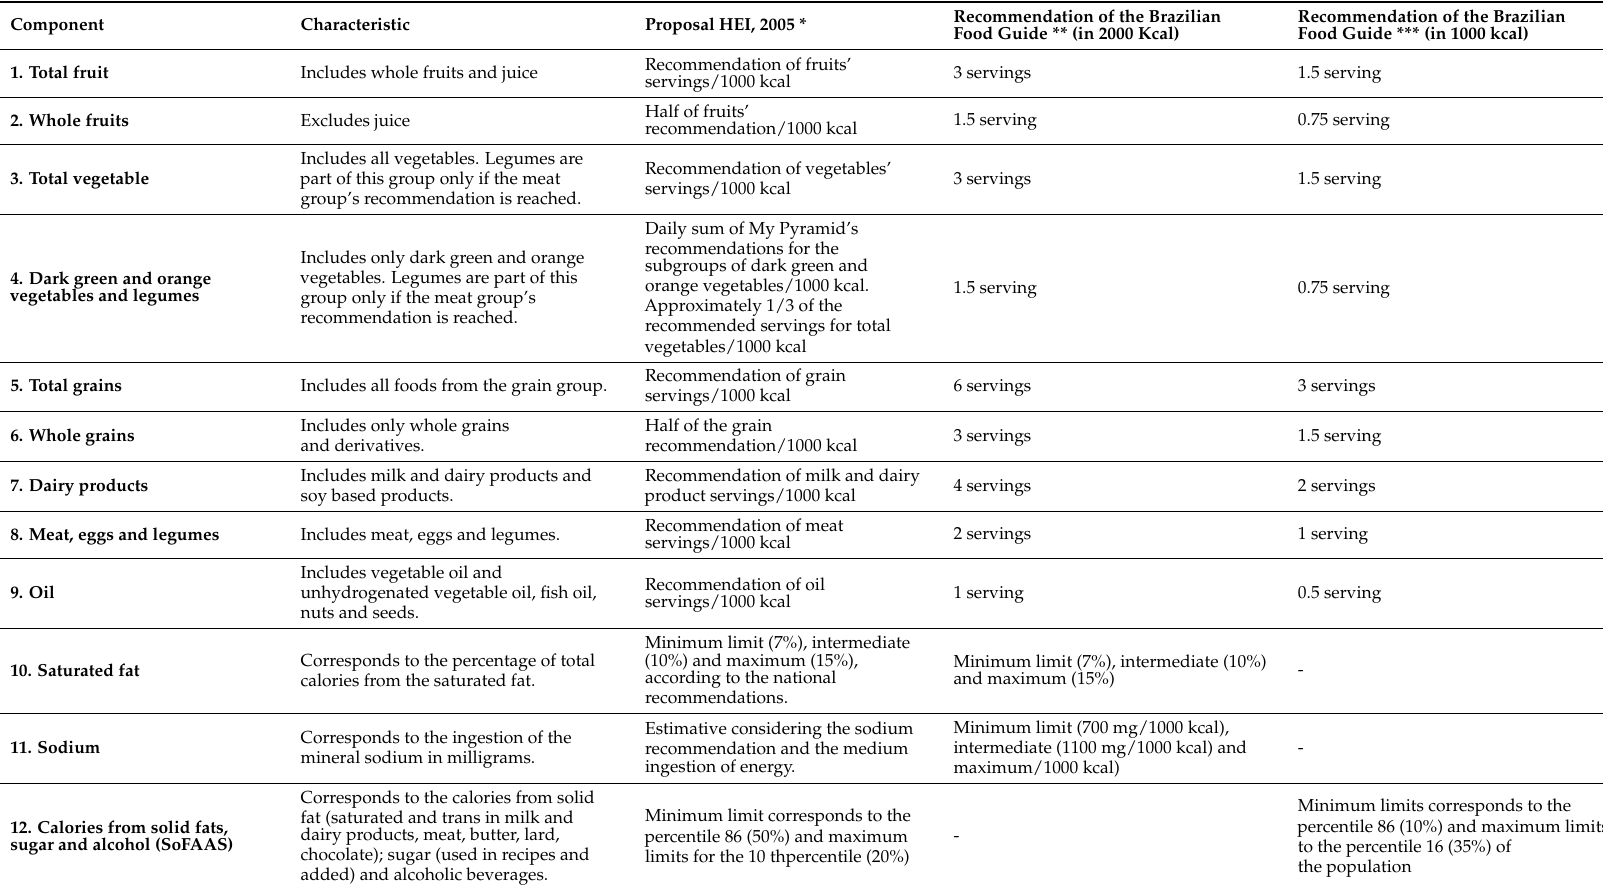
Table 1. Adaptation of the methodology for assessment the Healthy Eating Index (HEI) for the Brazilian